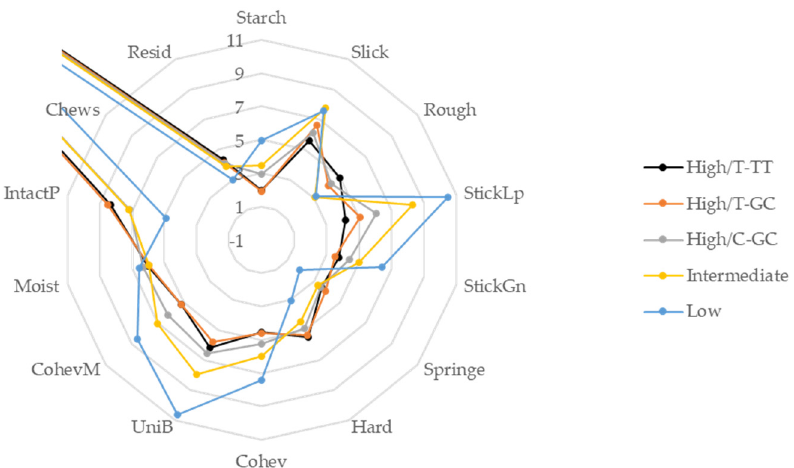
Figure 2. Spider graph of 14 texture attributes of three high amylose haplotypes (High/T-TT, High/T-GC, High/C-GC), intermediate amylose and low amylose types. Values for Chews are 32.8, 33.2, 30.8, 30.7 and 23.0 for High/T-TT, High/T-GC, High/C-GC, Intermediate and Low, respectively.